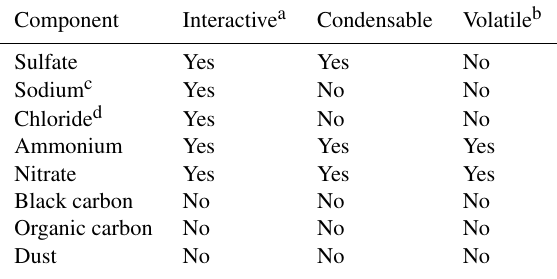
Table 4. Phase transition properties of aerosol components in HyDiS-1.0 extended